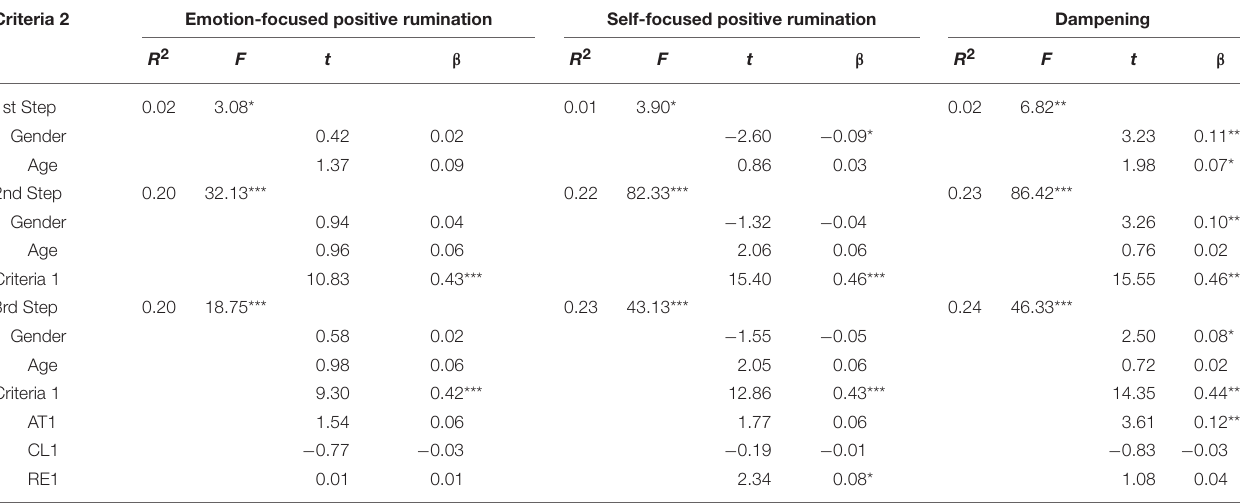
TABLE 2 | Stepwise regression analyses for responses to positive affect as criteria variables. Criteria 2